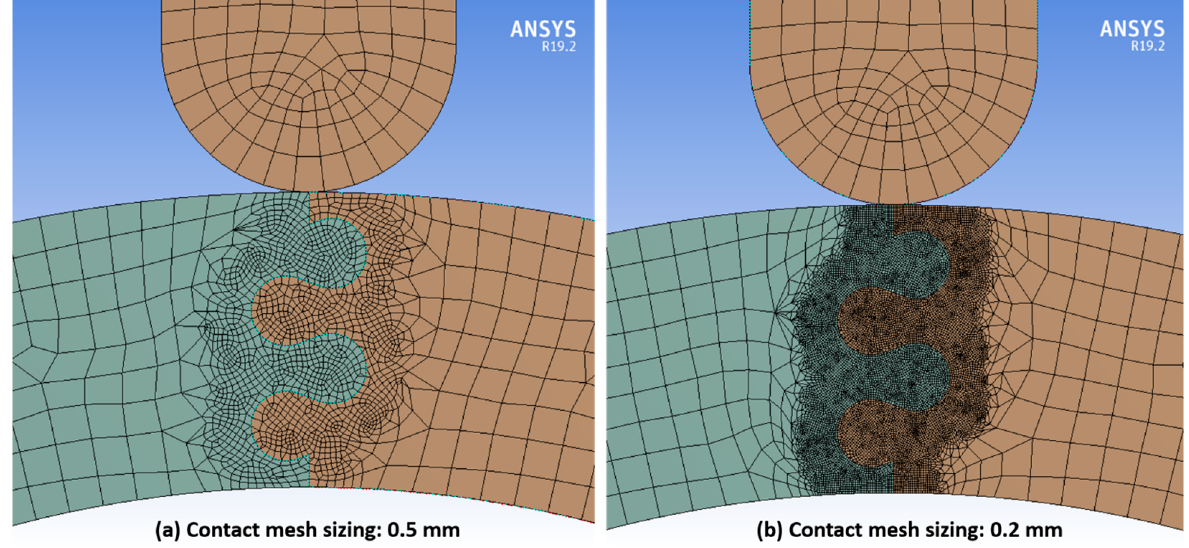
Figure 6. Mesh near the contacting surfaces of the suture for an archway with a contact angle of 20°, tab radius of 3 mm, and tangent length of 2 mm with ( a ) the initial fine contact mesh sizing of 0.5 mm, and ( b ) the updated extra-fine contact mesh sizing of 0.2 mm.